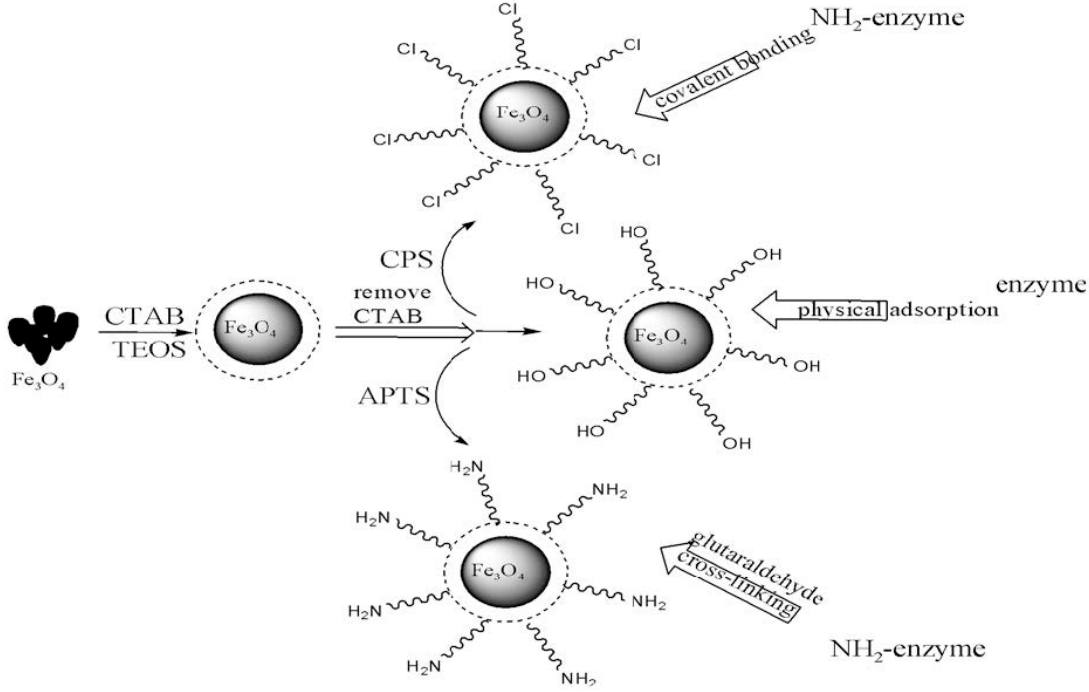
Figure 66. Schematic representation of Fe 3 O 4 -MCM-41 nanoparticles formation and enzyme immobilization. Reproduced with permission from [172]. Copyright 2015 Springer.